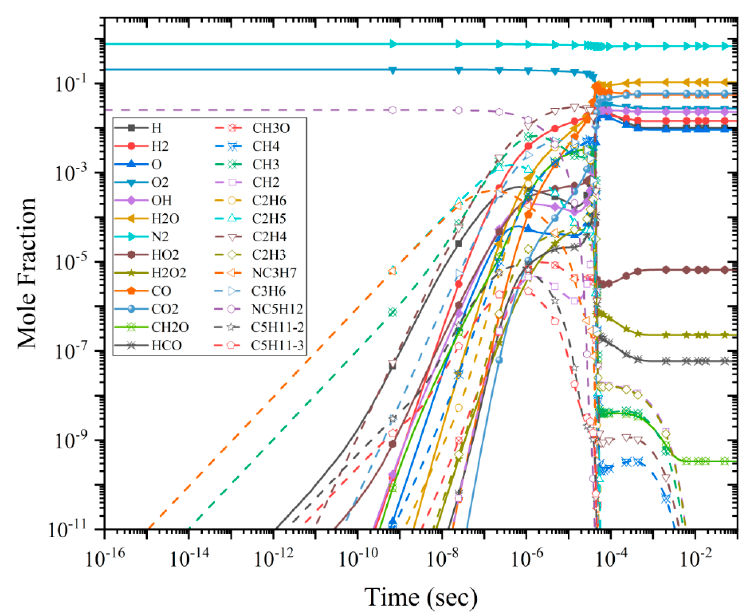
Figure 4. The changes of species calculated with DGPA at an equivalent ratio of 1.0 and a temperature of 1600 K.